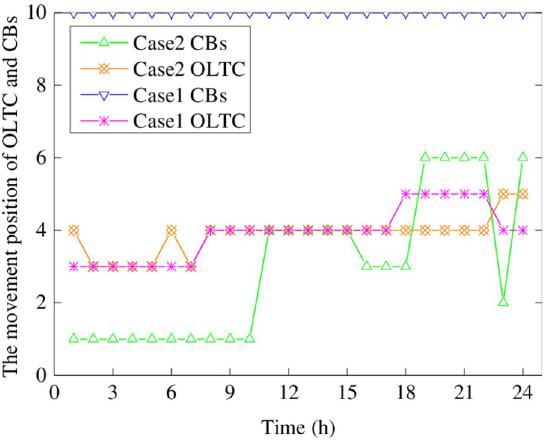
Fig 5. The movement position of OLTC and CBs.